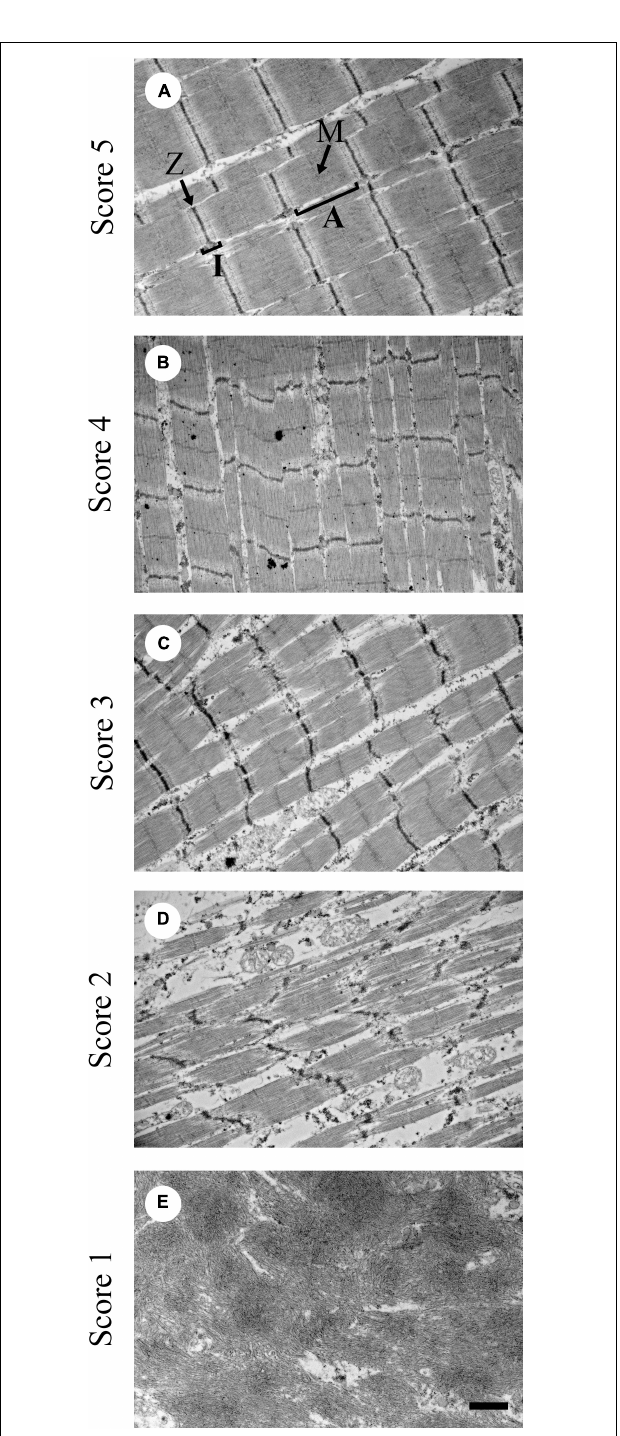
FIGURE 1 | Representative transmission electron microscopy images for sarcomere organization scoring from 1 to 5. (A) Score of 5 shows sarcomeres with normal structure; (B) score of 4 means mildly altered; (C) score of 3 means further disorganized from a score of 4 but still moderate; (D) score of 2 means severely altered sarcomere structure; and (E) score of 1 means complete absence of sarcomere structure. A = A zone; I = I zone; M = M-line; Z = Z-line. Bar = 1 µ m. (Figure reproduced from Velleman et al., 2018. Avian Dis. 62, 28–35).